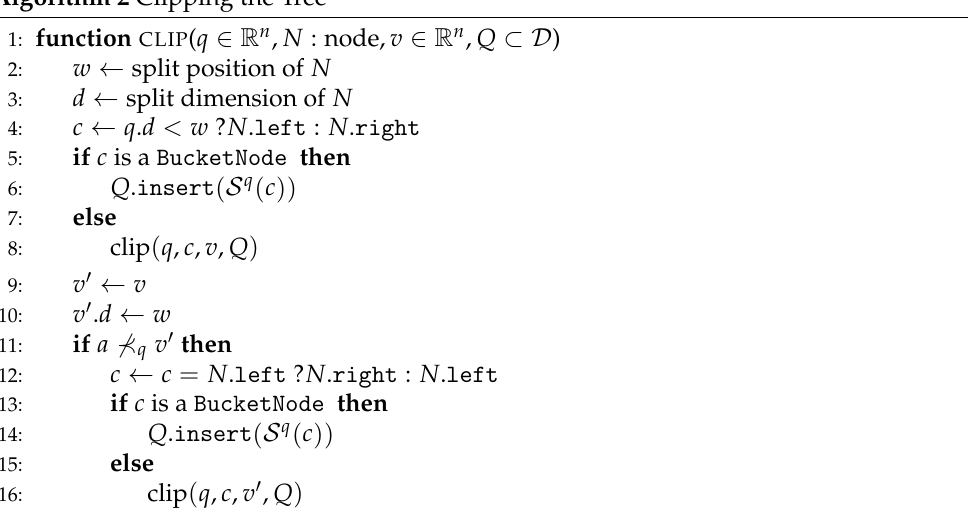
Algorithm 2 Clipping the